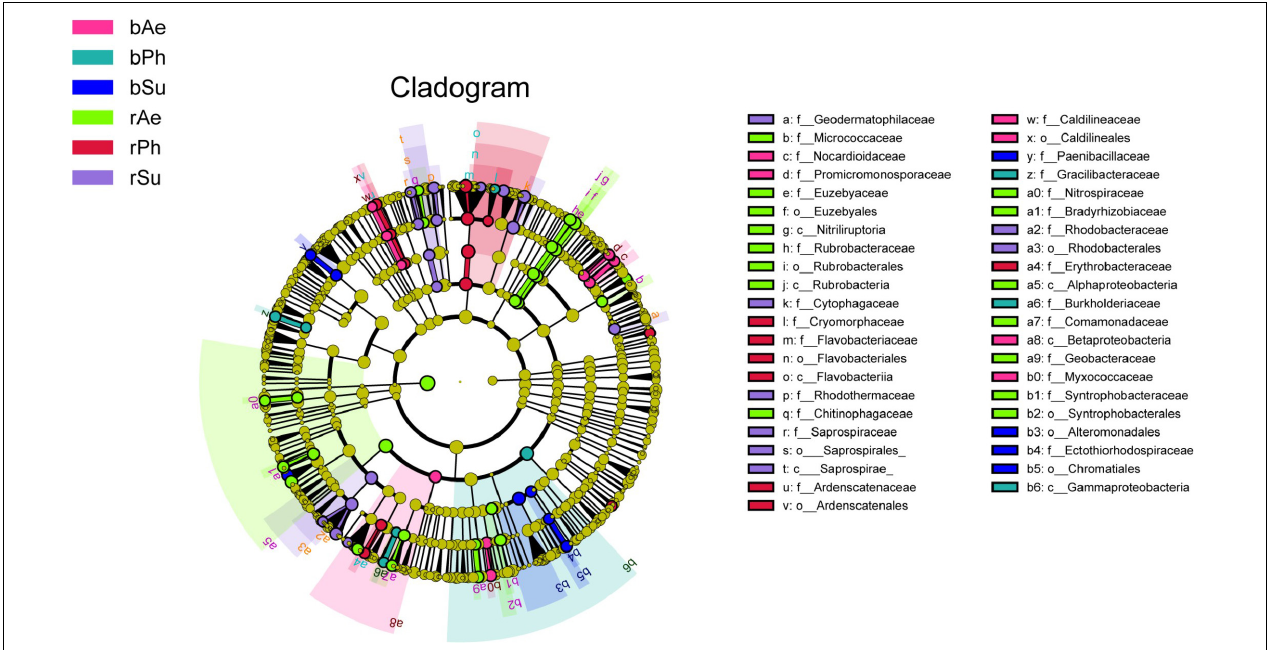
FIGURE 7 | LEfSe analysis of bacteria with a significant difference in classification level between rhizosphere and bulk soil of three halophytes (LDA > 2). c_, Class; o_, Order; f_, Family.